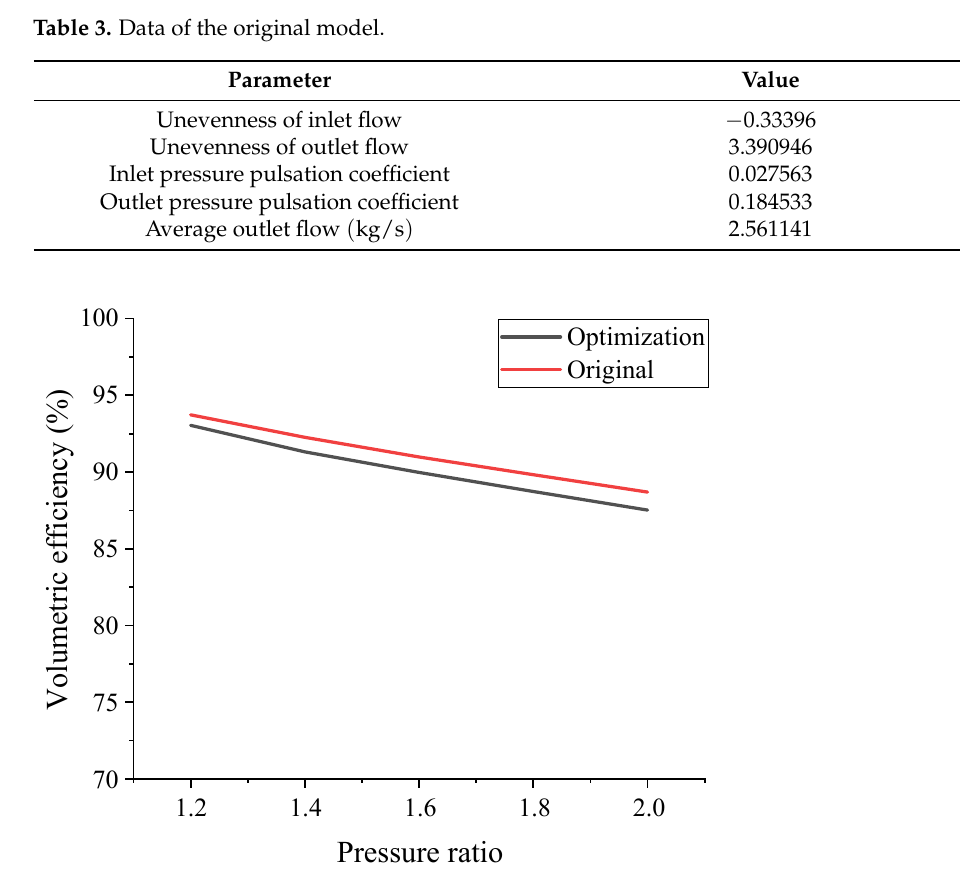
Figure 9. The volumetric efficiency of the optimization and the original with different pressure ratios.